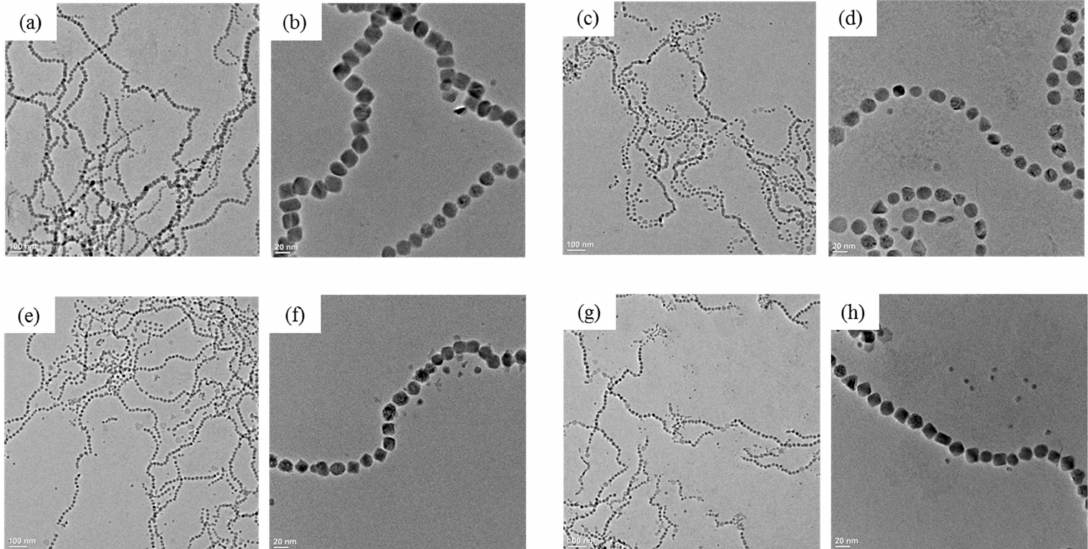
Figure 3. TEM images of PS-Co NPs synthesized with the concentration of cobalt carbonyl fixed at 21.9 mM, and with different concentration of PS-NH 2 ( M n = 4500 g/mol, C PS ): ( a , b ) C PS = 5 mM, D = 21.4 ± 1.9 nm; ( c , d ) C PS = 2.5 mM, D = 20.4 ± 2.1 nm; ( e , f ) C PS = 1.25 mM, D = 19.5 ± 1.5 nm; ( g , h ) C PS = 0.63 mM, D = 18.4 ± 3.0 nm. The PS–Co NP samples were prepared on TEM grid from the respective NP dispersion in DCB. The mean size and standard deviation were obtained from a sample of around 200 NPs using ImageJ